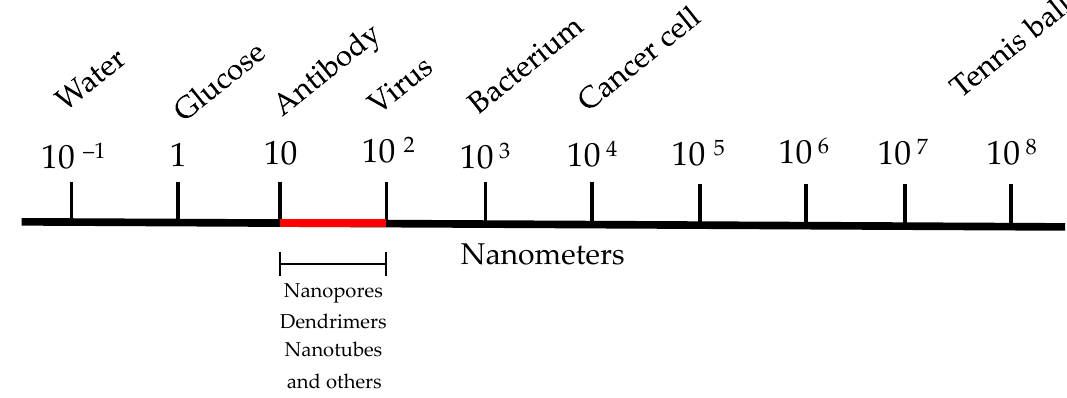
Figure 2. Diagrammatic r epresentation of the size range of material in nanotechnology.